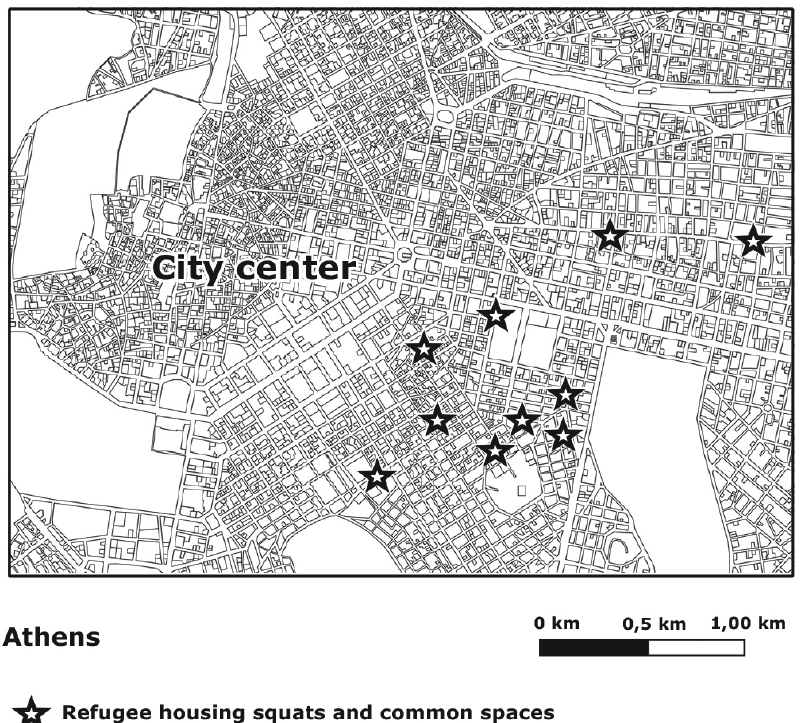
Figure 6. Refugee housing squats and common spaces in Athens. Source: Authors, map based on the land uses map of Regulatory Urban Plan of Athens and Thessaloniki Metropolitan Areas (2014).